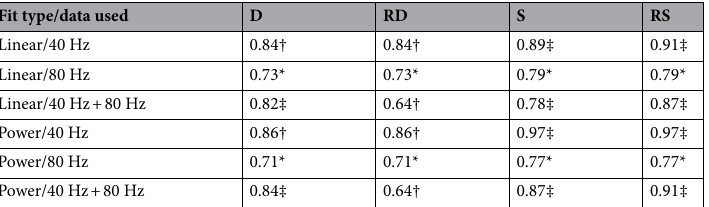
Table 1. R 2 values for linear and power functions fit to each of the predictors in (Fig. 4). Separate functions are reported for each frequency as well as two frequencies combined. Significance level is denoted as ‡: p < 0.0001, †: p < 0.001, * : p <